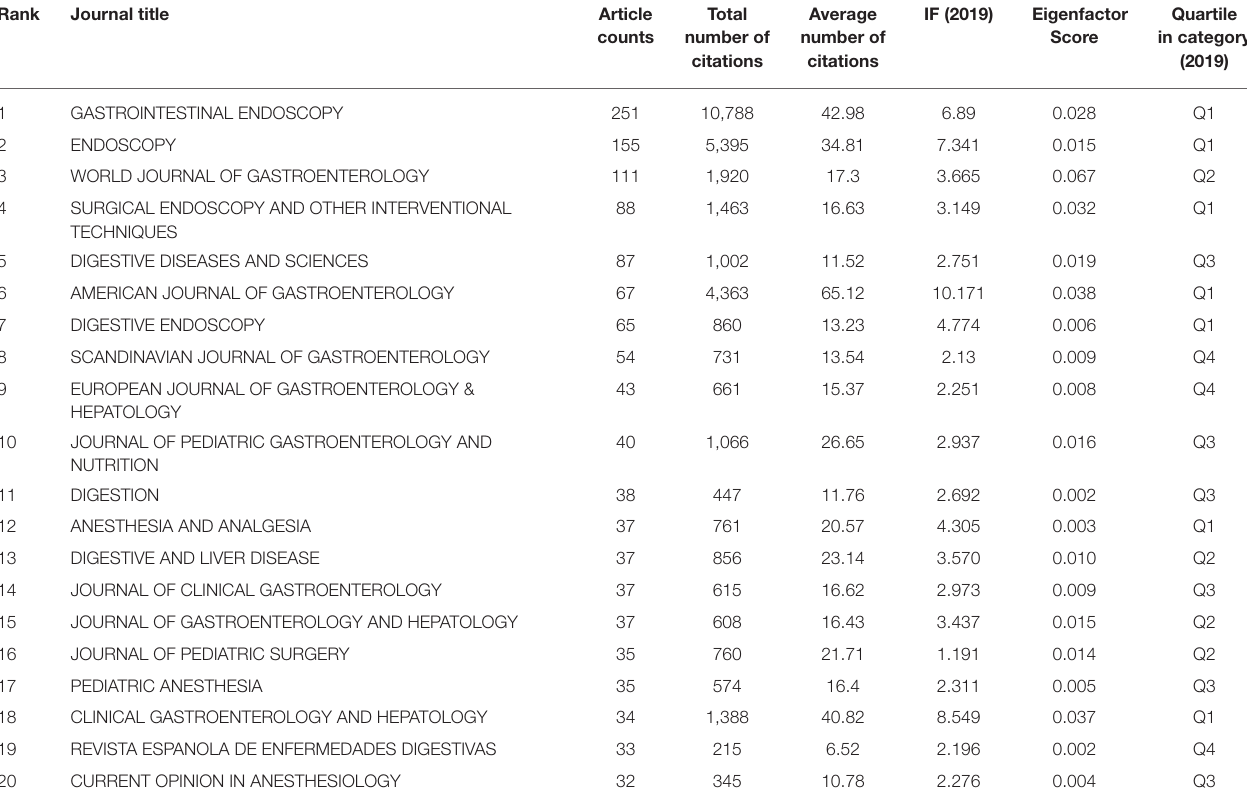
TABLE 2 | The top 20 most active journals that published articles (sorted by